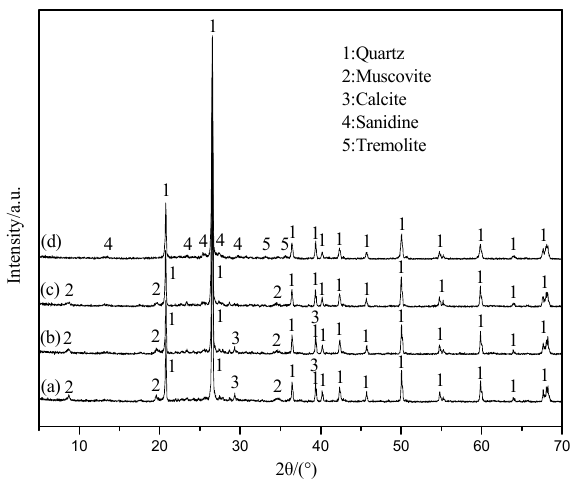
Figure 6. XRD patterns of the samples roasted with 3 wt % MgO at different roasting temperatures for 1 h. ( a ) 400 °C; ( b ) 500 °C; ( c ) 700 °C; and ( d ) 900 °C.